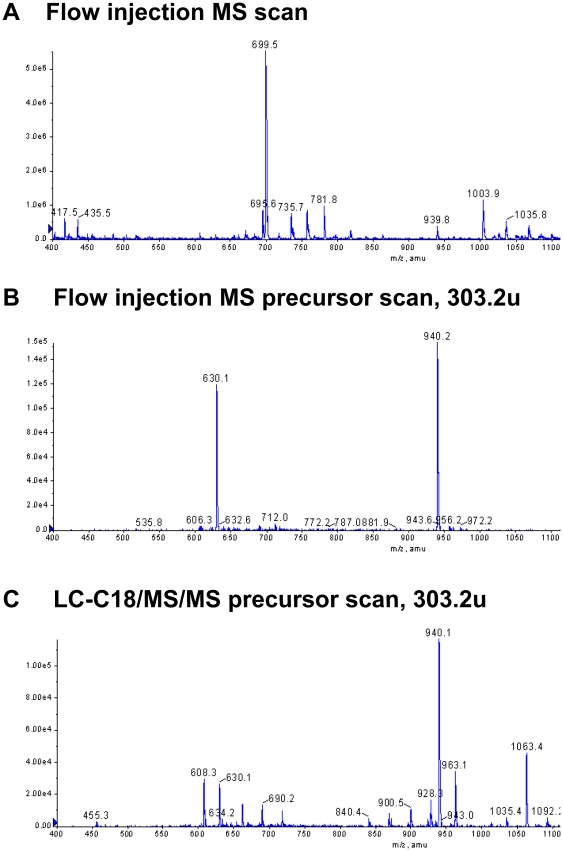
Arachidonyl group was transferred onto phosphatidic acid.(A) PA was incubated with the TIP30 protein complex in the fusion buffer. Resulting lipids were purified and subjected to flow injection negative scan in the range of 400–1400 u. A predominant peak of 699.5 was detected. Atomic mass: arachidonic acid, 304.5 u; 18:1 PA, 699.5 u. The lipids in the smaller peaks have molecular weights that do not match any of the expected PA derivatives. (B) The flow injection negative precursor scan for 303.2 u over a mass range of 400–1400 u. (C) The LC-C18 negative precursor scan for 303.2 u over a mass range of 400–1400 u. The lipids after the acylation reaction was extracted and chromatographed on a C-18 column to reduce possible adduction mechanisms of compounds detected in the flow injection negative precursor scan of 303.2 u.